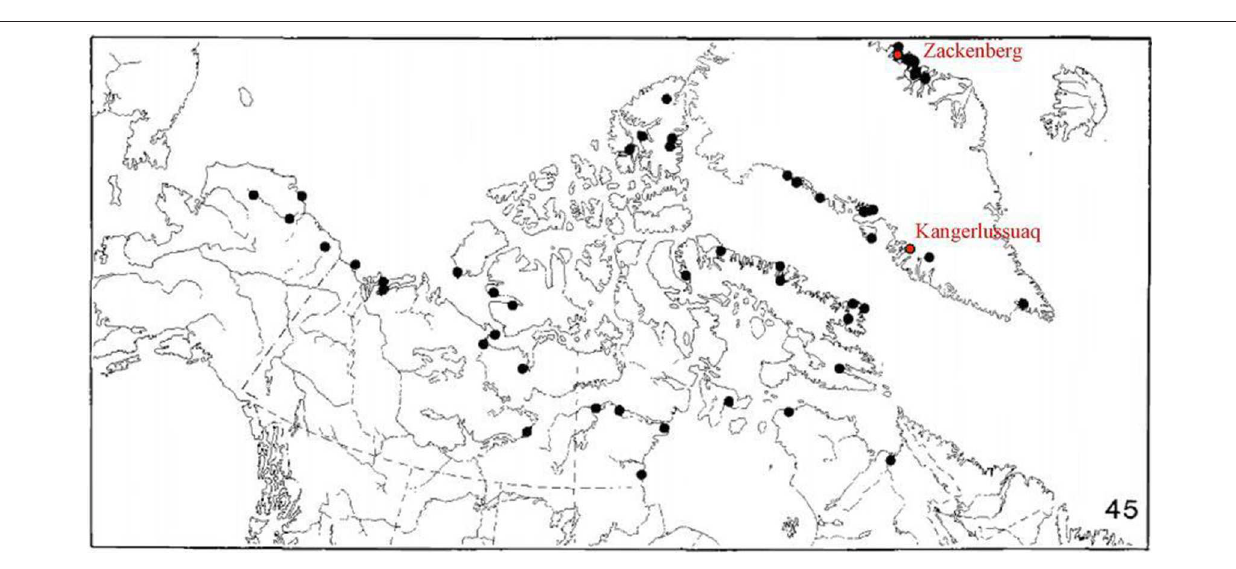
FIGURE 2 | Map of the distribution of the arctic wolf spider Pardosa glacialis (Figure modified and reproduced with permission from Dondale and Redner, 1990). Egg sacs of P. glacialis were sampled and inspected for evidence of parasitism from Zackenberg (74.47 ◦ N 20.57 ◦ W), a high-arctic site in NE Greenland,